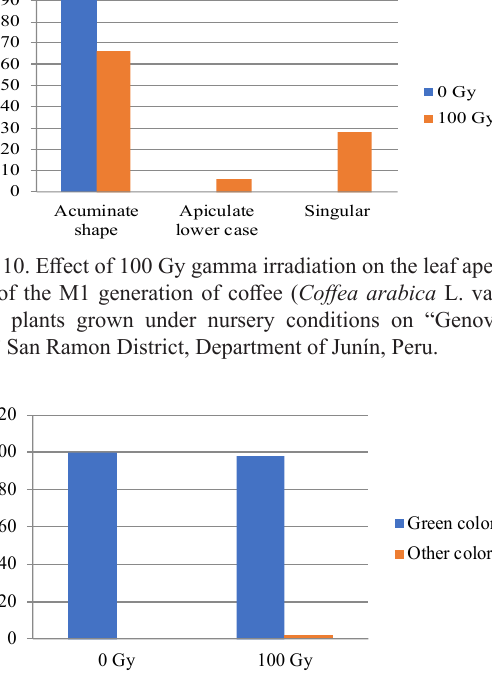
Figure 11. Effect of 100 Gy gamma irradiation on the leaf color of the M1 generation of coffee ( Coffea arabica L. var. typica) plants grown under nursery conditions on “Genova Farm,” San Ramon District, Department of Junín, was observed in 2 % of the M1 plants (Figure 11). Some plants had yellow-green color and white and yellow stripes or spots.